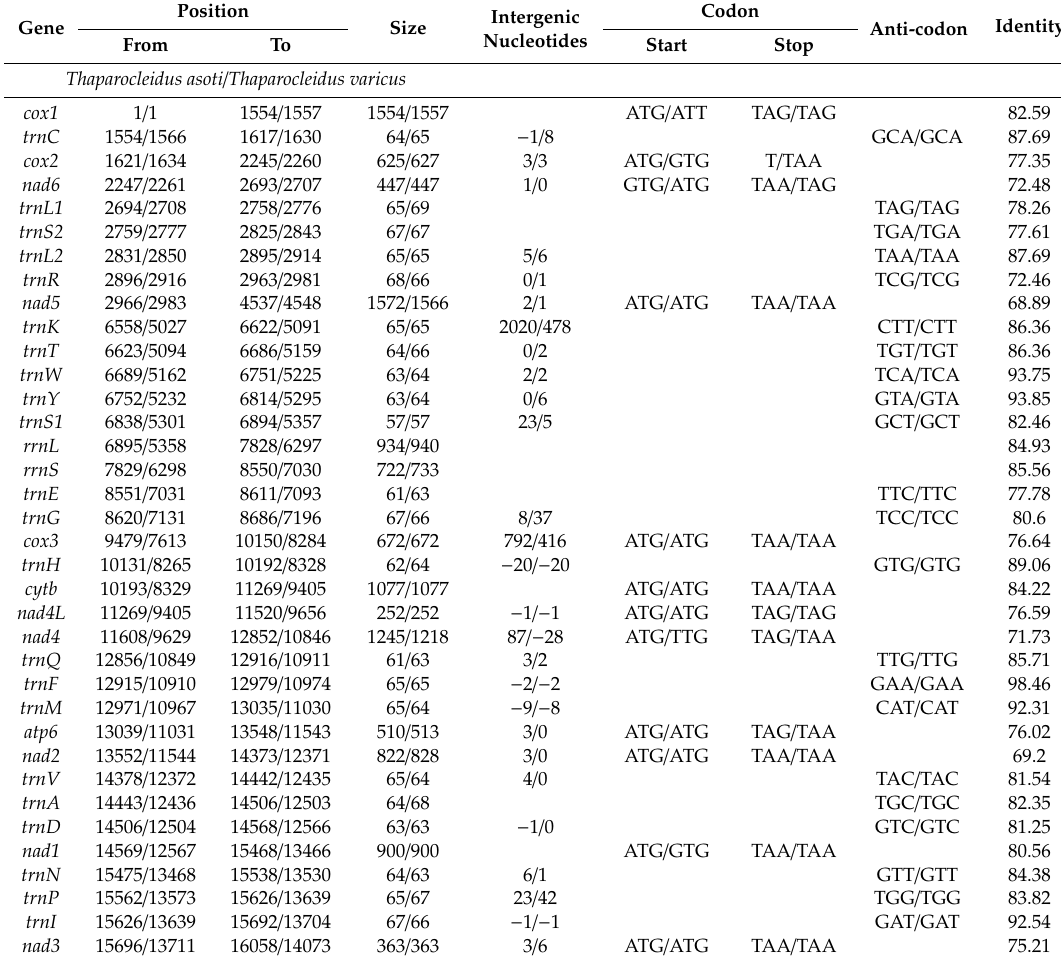
Table 1. Comparison of the annotated mitochondrial genomes of Thaparocleidus asoti and Thaparocleidus varicus . Negative values in the ‘Intergenic Nucleotides’ column indicate